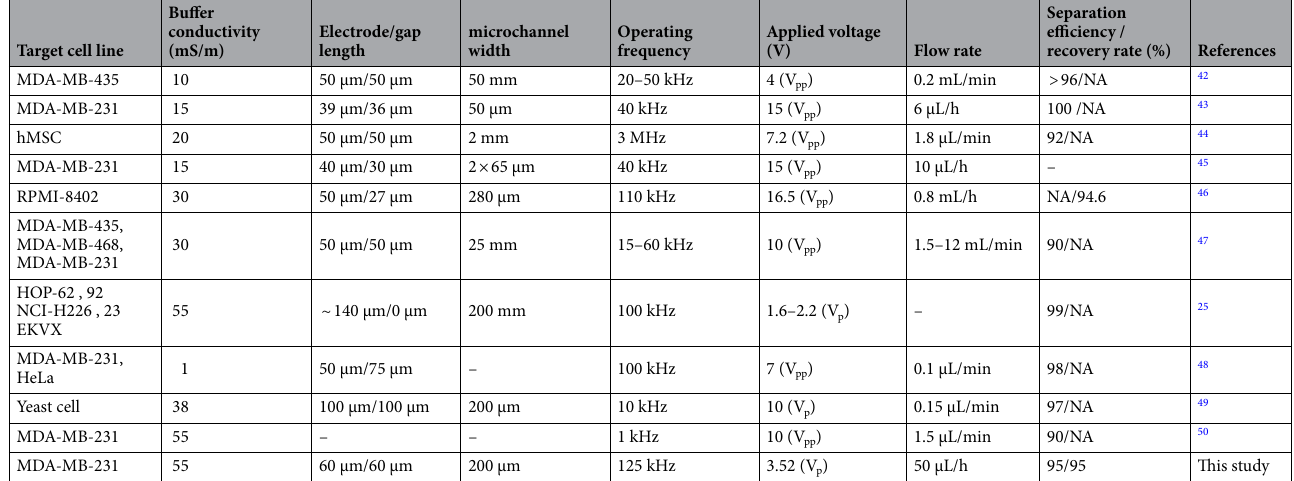
Table 2. A comparison of proposed DEP device with previously reported papers.